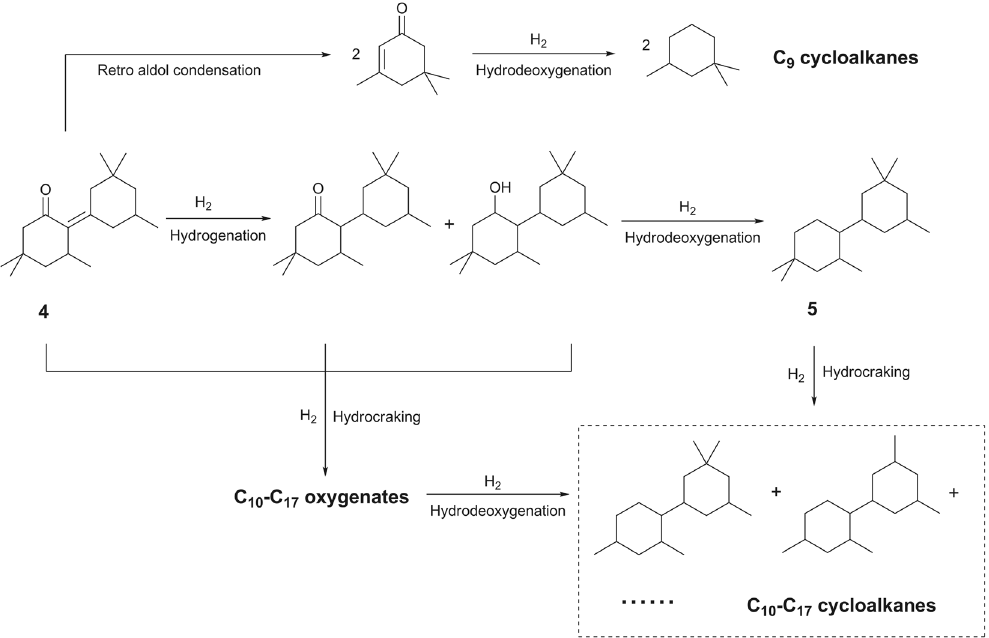
Figure 6. Reaction pathways for the production of different cycloalkanes from the solvent-free HDO of compound